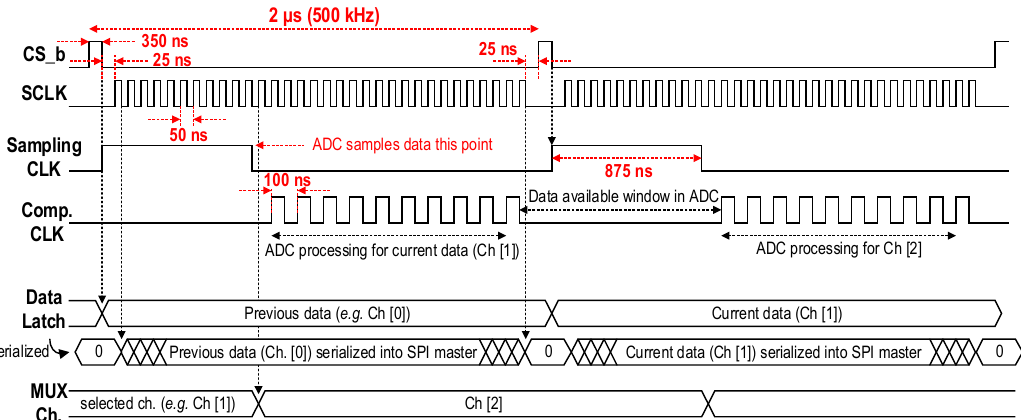
Figure 10. Timing diagram for serial peripheral interface (SPI) operation.